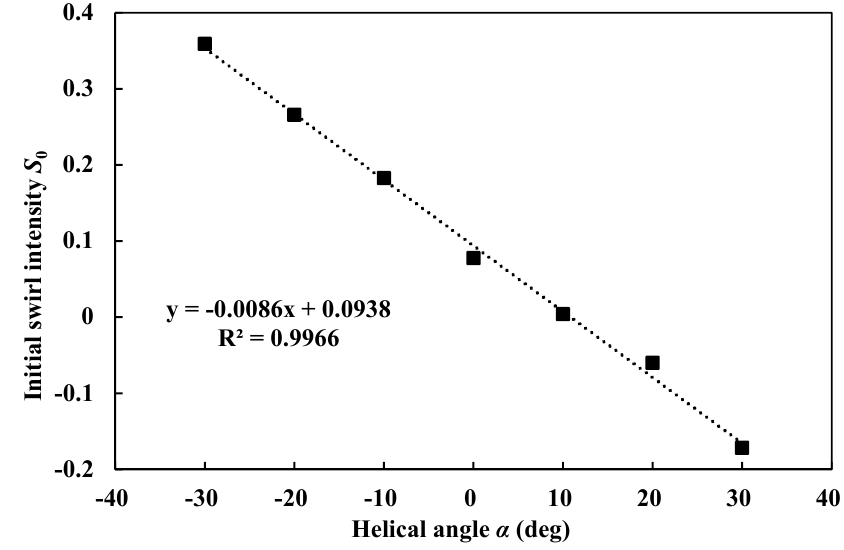
Figure 9. Fitting curve of the relationship between helical angle and initial swirl intensity for the straight blade.